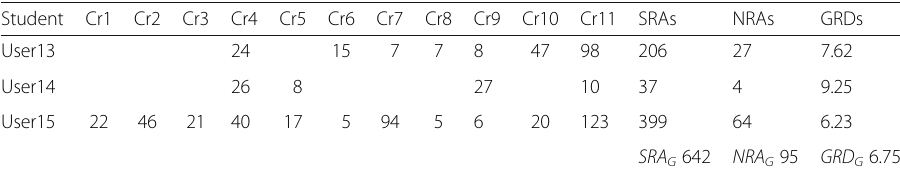
Table 3 Marks for members of Project4